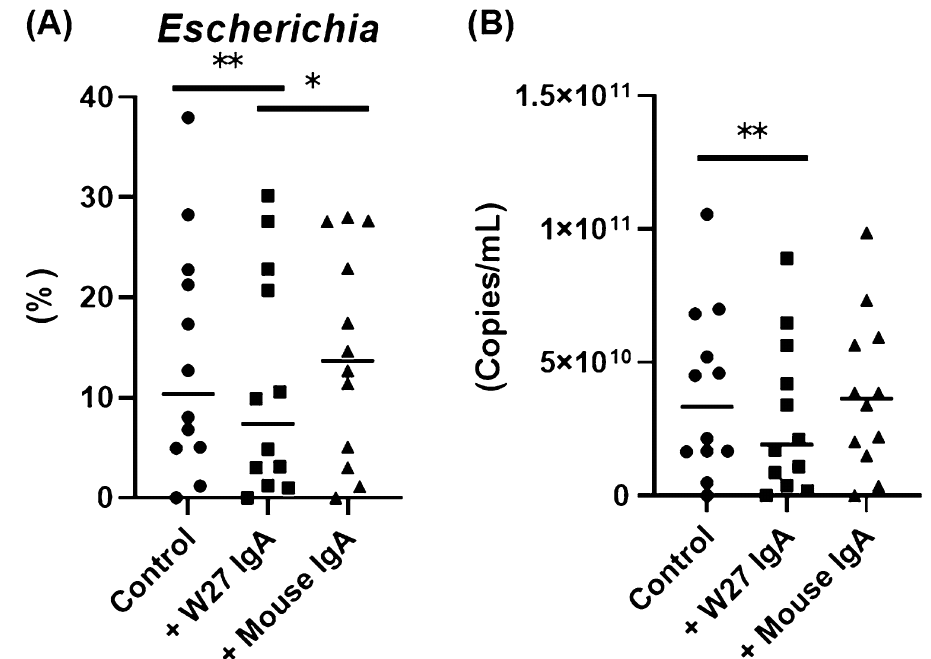
Figure 3. The relative abundance distributions ( A ) and absolute copy numbers ( B ) of genus Escherichia in KUHIMM (n = 12). The distribution for each group is shown (Control, + W27 IgA, and + Mouse IgA). The bars represent mean of twelve technical/biological replicates. Escherichia copy number = (Total copy number) × (Relative abundance). ** p < 0.01, and * p < 0.05, Wilcoxon signed-rank test.